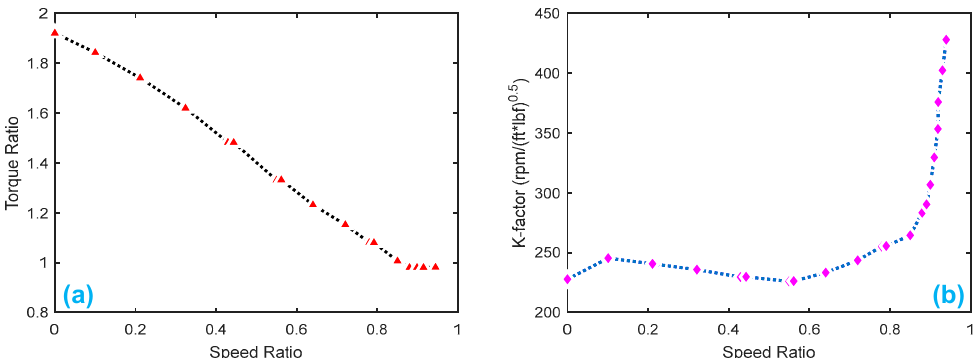
Figure 13. Torque converter characteristics of the HTC in a Honda CRV from Pohl’s paper: ( a ) torque ratio by speed ratio; ( b ) K-factor by speed ratio.